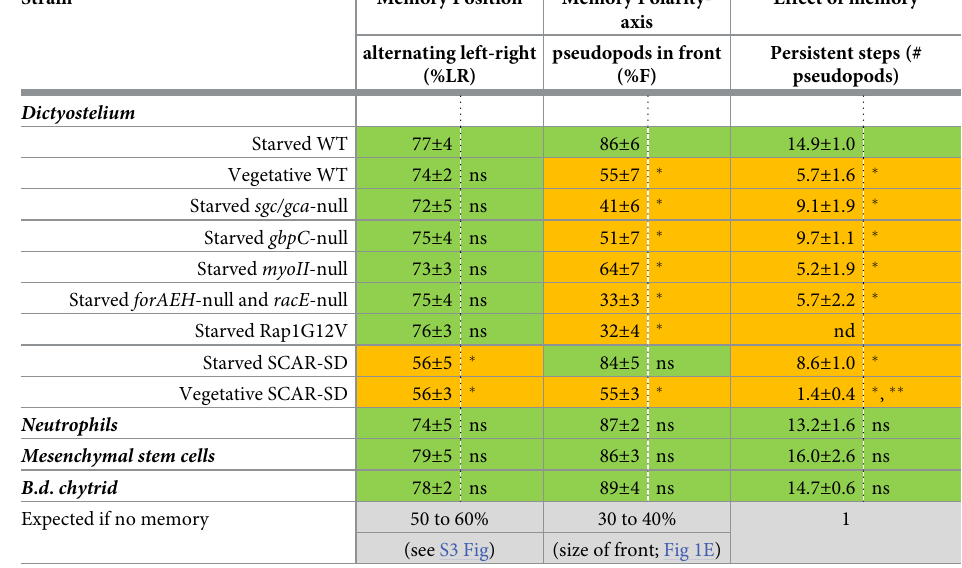
Table 1. Memory of position and polarity axis in Dictyostelium mutants and other species. Strain